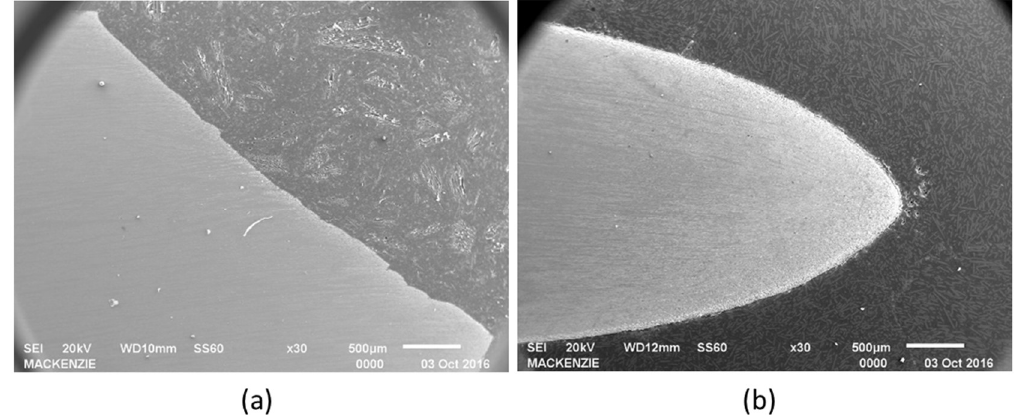
Figure 6. Micrographs of the longitudinal sections of tensile fracture for the Inconel 625 specimens tested at ( a ) 500 and ( b ) 800 °C.